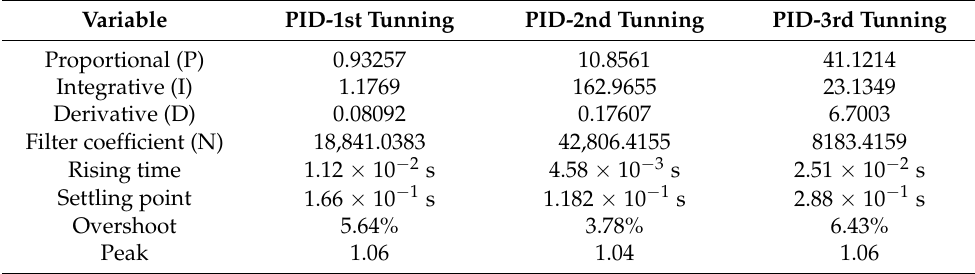
Figure 11. PID tunning process. ( a ) Step response for PID tuning, ( b ) Proposed trapezoidal profile for the change of position. Table 5. Computed values for the tunning process of PID